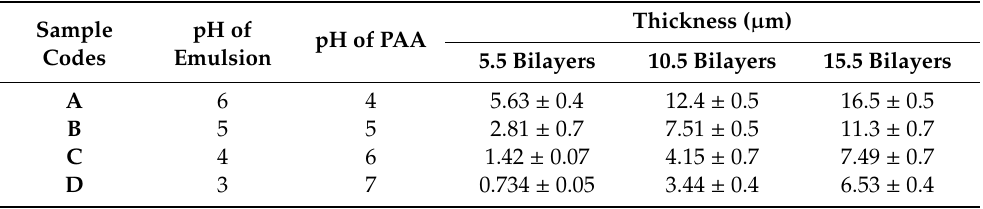
Table 2. Thickness measurement of samples A, B, C and D at various pH combinations.